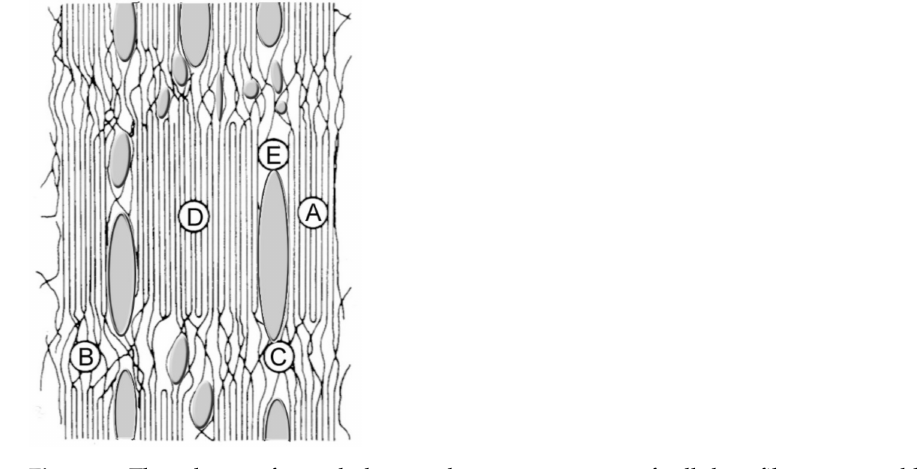
Figure 5. The scheme of morphology and porous structure of cellulose films prepared by MMO- process: A —crystallites, B —amorphous regions, C —strands, D —clusters, and E